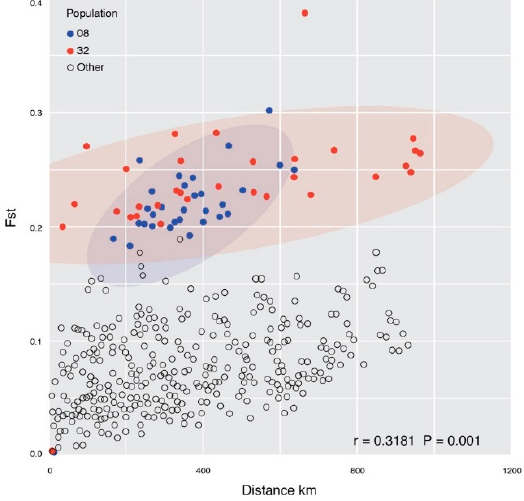
Figure 4. Mantel test ( F ST by distance), pairwise comparisons involving population 08-Mount Ka- putar National Park (western extreme), are highlighted in blue and population 32-Brogo (southern extreme), in red. Individuals from all other populations are shown in black.